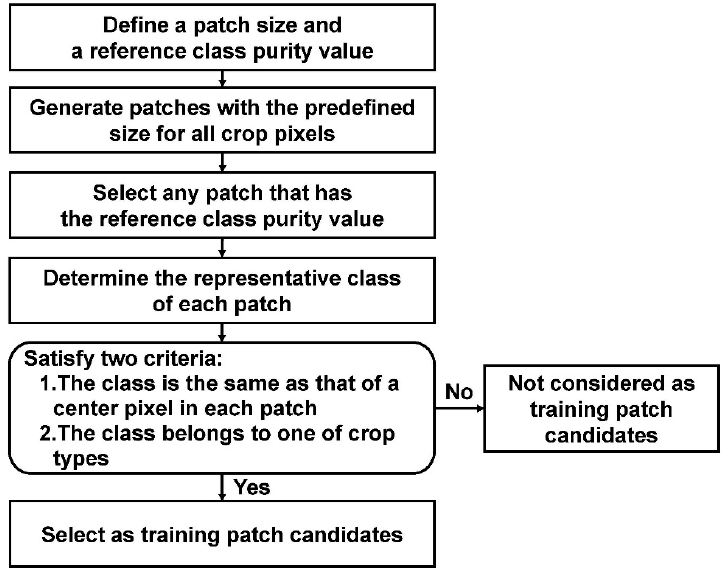
Figure 4. Flow chart of selection of training patch candidates with respect to class purity and patch size.